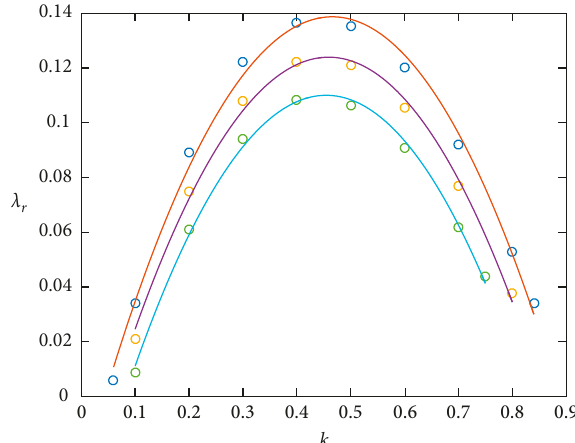
Figure 4: Quadratic approximations of the growth rates for the following values of the parameters: S � 0.07, 0.09, and 0.11 (from top to